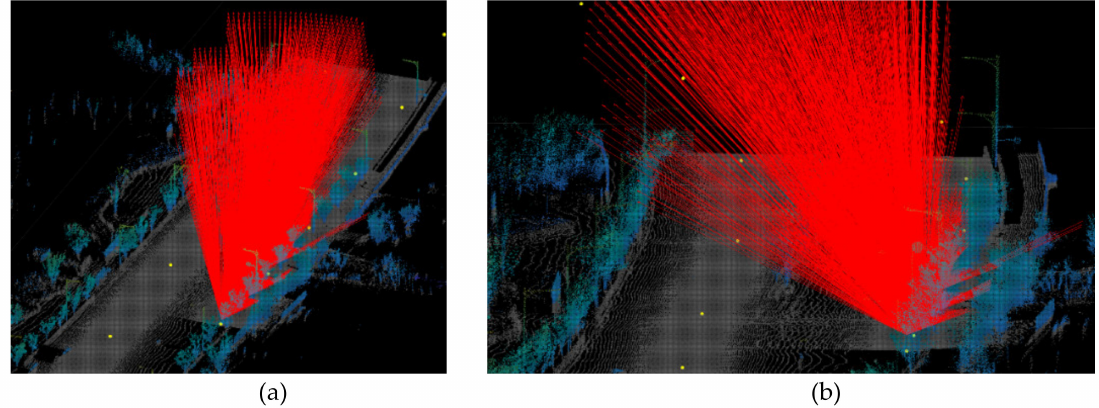
Figure 6. Visualization of the raycasting method with point cloud data. ( a ) Example visualization ( b ) Detailed visualization on the street with